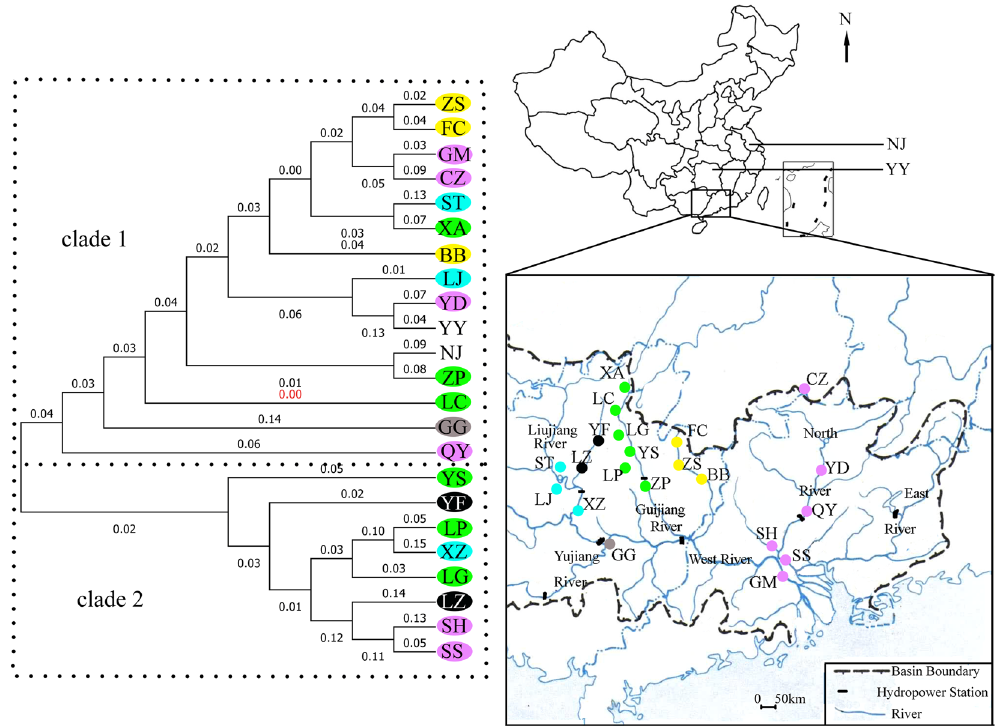
Figure 3. Neighbour-joining network based on Nei’s genetic distance for twenty-three populations of P. clarkii . Maps were obtained from the Pearl River Water Resources Commission 53 . Colour solid dots on maps indicate sample sites. Populations with the same colour are distributed in a river. Lipu (LP), Lingui (LG), Yongfu (YF), Yangshuo (YS), Xing’an (XA), Lingchuan (LC), Shatang (ST), Luzhai (LZ), Liujiang (LJ), Xiangzhou (XZ), Guigang (GG), Babu (BB), Zhaoping (ZP), Zhongshan (ZS), Fuchuan (FC), Yingde (YD), Qingyuan (QY), Sihui (SH), Gaoming GM), Sanshui (SS), Chenzhou (CZ) Yueyang (YY) and Nanjing